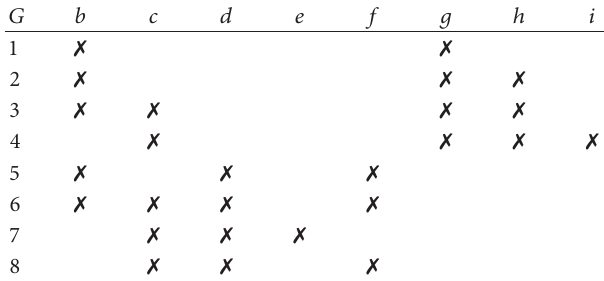
Table 2: Living beings and water (𝐺, 𝑀, 𝐼)